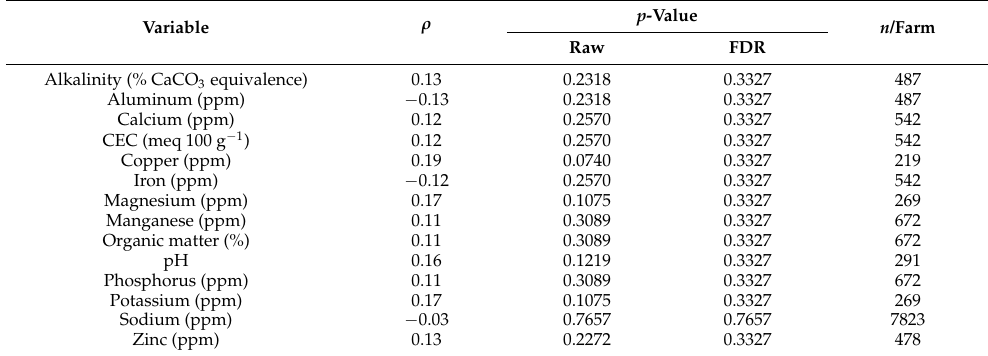
Table 4. Results from correlation analysis tests between log 10 CFU g − 1 of vAh and sediment chemistry variables. Based on bivariate normality testing, test used was Spearman’s rank correlation (coefficient = ρ ). All raw p -values were adjusted to control the false discovery rate (FDR) using the Benjamini– Hochberg procedure. Significant results at p < 0.05. The sample size ( n ) required to reveal statistically significant